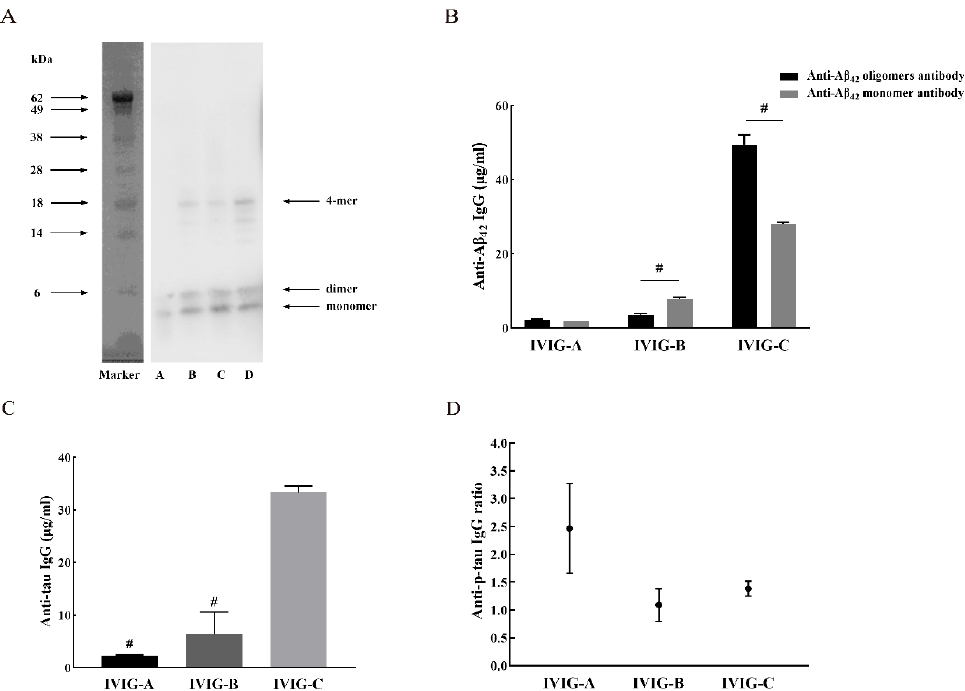
Figure 1. ( A ) WB of A β 42 preparations was generated in various conditions. Lane A: monomeric A β (MW 4.5 kDa) generated by resuspending lyophilized A β 42 in TFA and HFIP to disaggregate it, followed by dissolving it in TFA water (pH 3.0) and adding Tris base and HCl to adjust the pH to 8.8. Lane B: A β 42 oligomers were generated by resuspending disaggregated A β 42 in DMSO, followed by bath sonication and aggregation for 3 days. Lanes C and D: A β 42 oligomers with aggregation for 5 days and 6 days, respectively. ( B ). Mean concentrations of antibodies to A β 42 monomer and oligomers in IVIG. Statistical signi fi cance using one-way ANOVA is de fi ned as # p < 0.001. ( C ). Results for anti-tau antibody concentrations for IVIG products are shown. Statistical signi fi cance using one-way ANOVA de fi ned as # p < 0.001 vs. IVIG-C group. ( D ). Results for anti-p-tau antibody ratios for IVIG products are shown. Three experiments were performed on each IVIG. Data are expressed as the mean ± SEM.